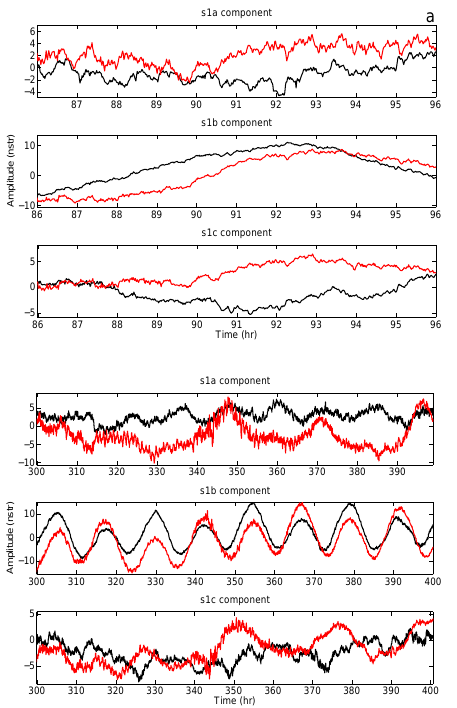
Figure 13. Residual noise level (high-pass filtered) on two data sets (black (June 2010) and red (December 2010)). (a) 10 hours of signal at 1-hour period. (b) 4 days of signal at 10-hours period.